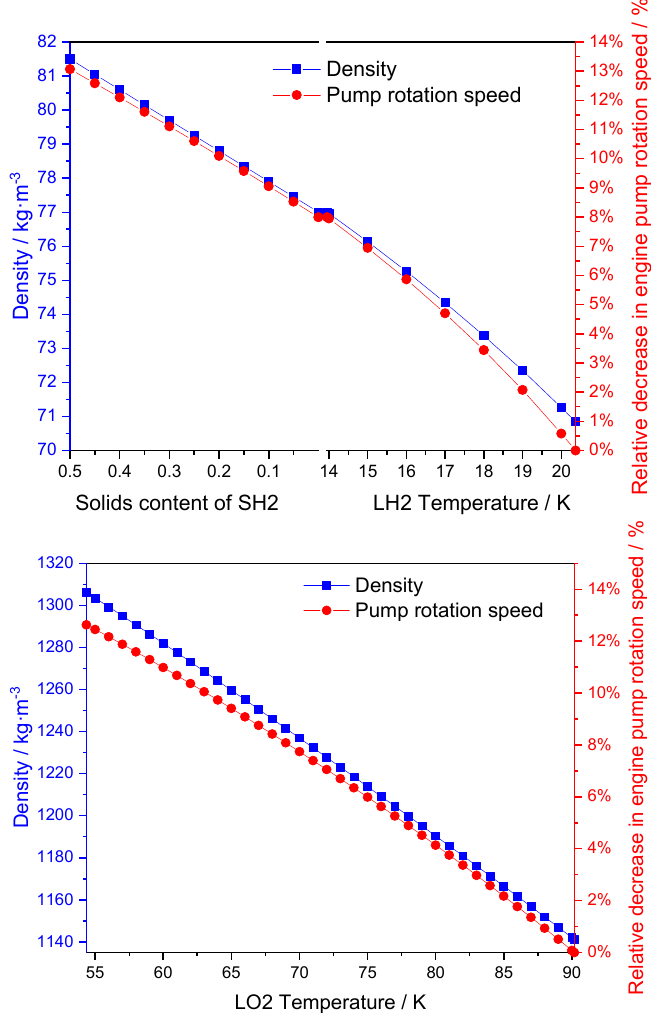
Figure 6. Relationship between LH2/LO2 densification degree and pump speed.